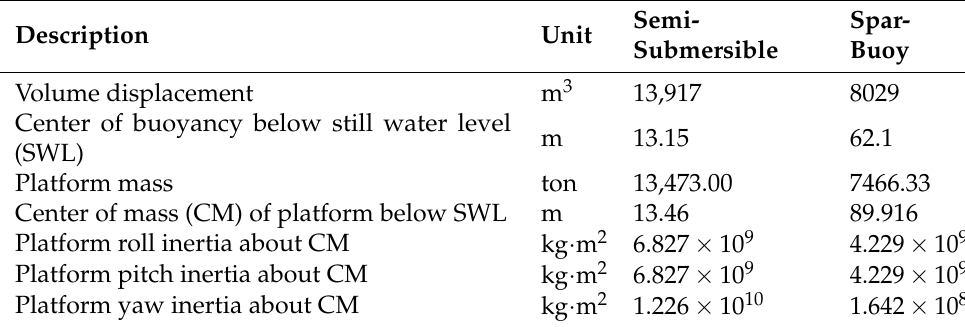
Table 1. Physical properties of the OC4 DeepCwind semi-submersible and the OC3 Hywind spar- buoy floating platforms [19,20].